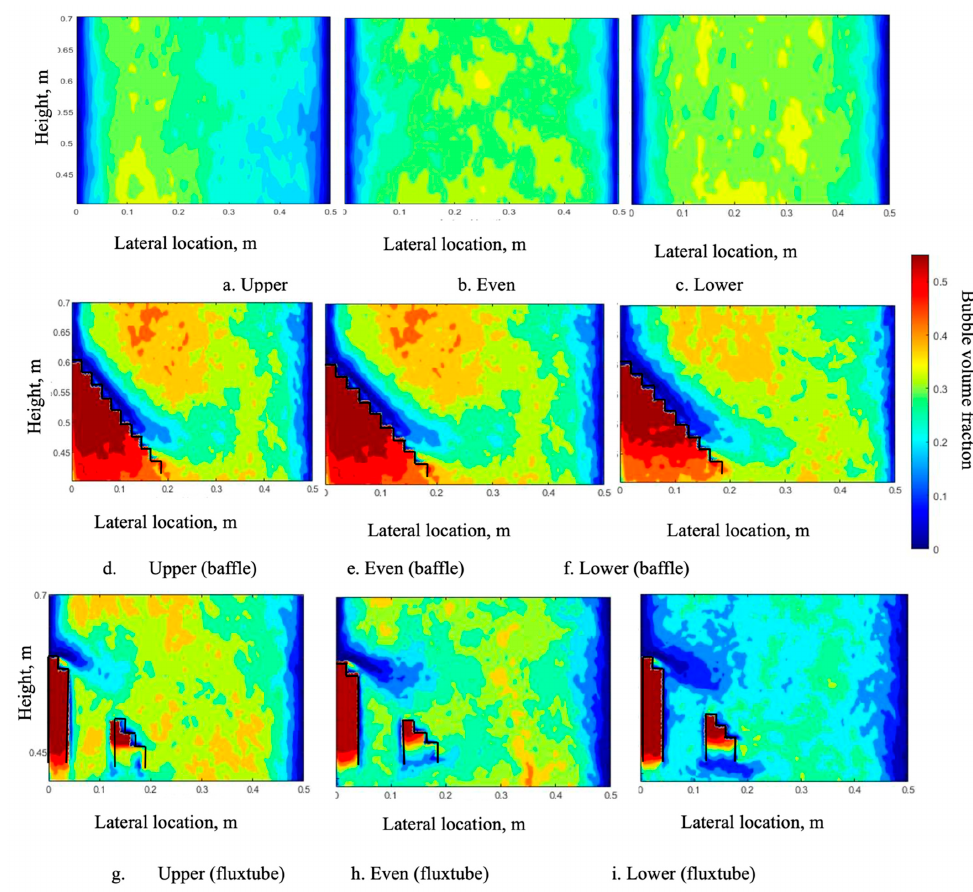
Figure 18. Bubble volume fraction contours at the baffle zone (0.40 m < y < 0.70 m) using the asymmetrical baffle without a fluxtube and with the regular fluxtube for different gas inlet configurations under the superficial gas velocity of 0.4 m/s .